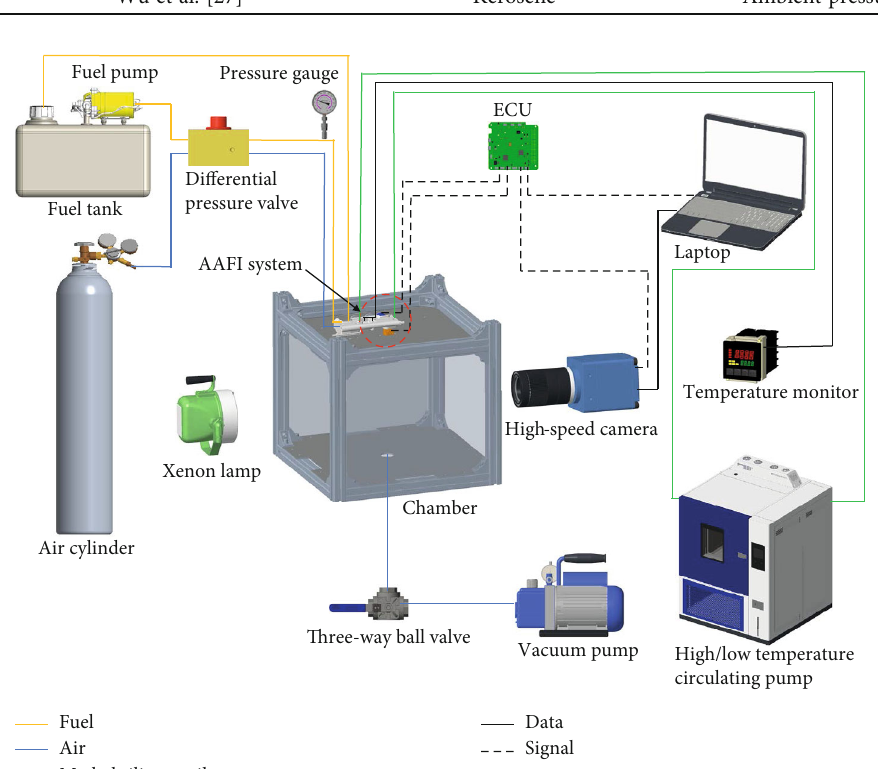
Figure 2: Schematic diagram of experimental